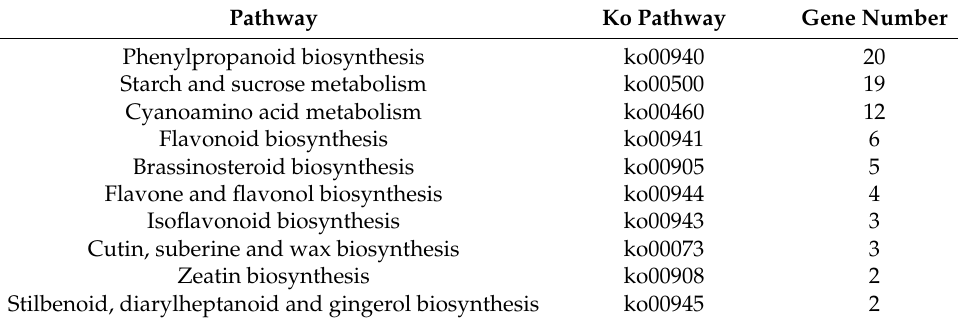
Table 1. Top ten pathways of HCN synthesis